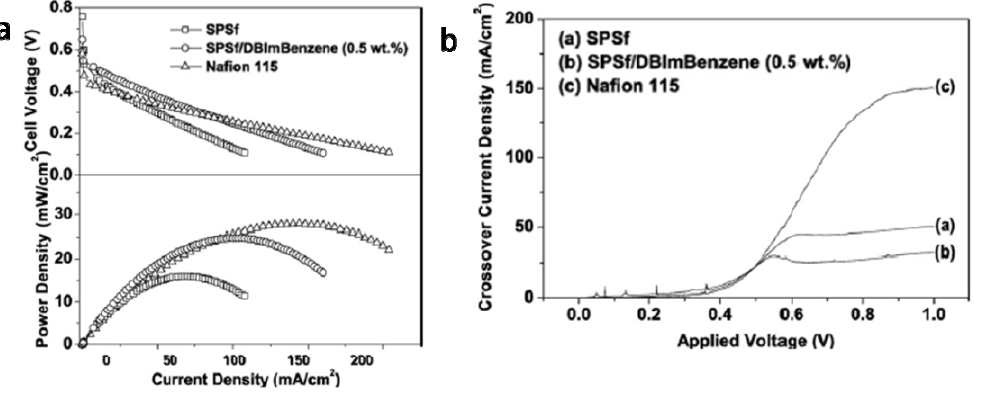
Figure 9. ( a ) Comparison of the polarization curves of the SPSf/DBImB blend membranes with those of plain SPSf and Nafion 115 membranes in DMFCs ( b ) comparison of the variations of the methanol crossover current density for the plain SPSf, Nafion 115, and SPSf/DBImB blend membranes in DMFCs. Methanol concentration: 1 M, temperature: 80 °C. (Reprinted with permission from [54]. Copyright 2008